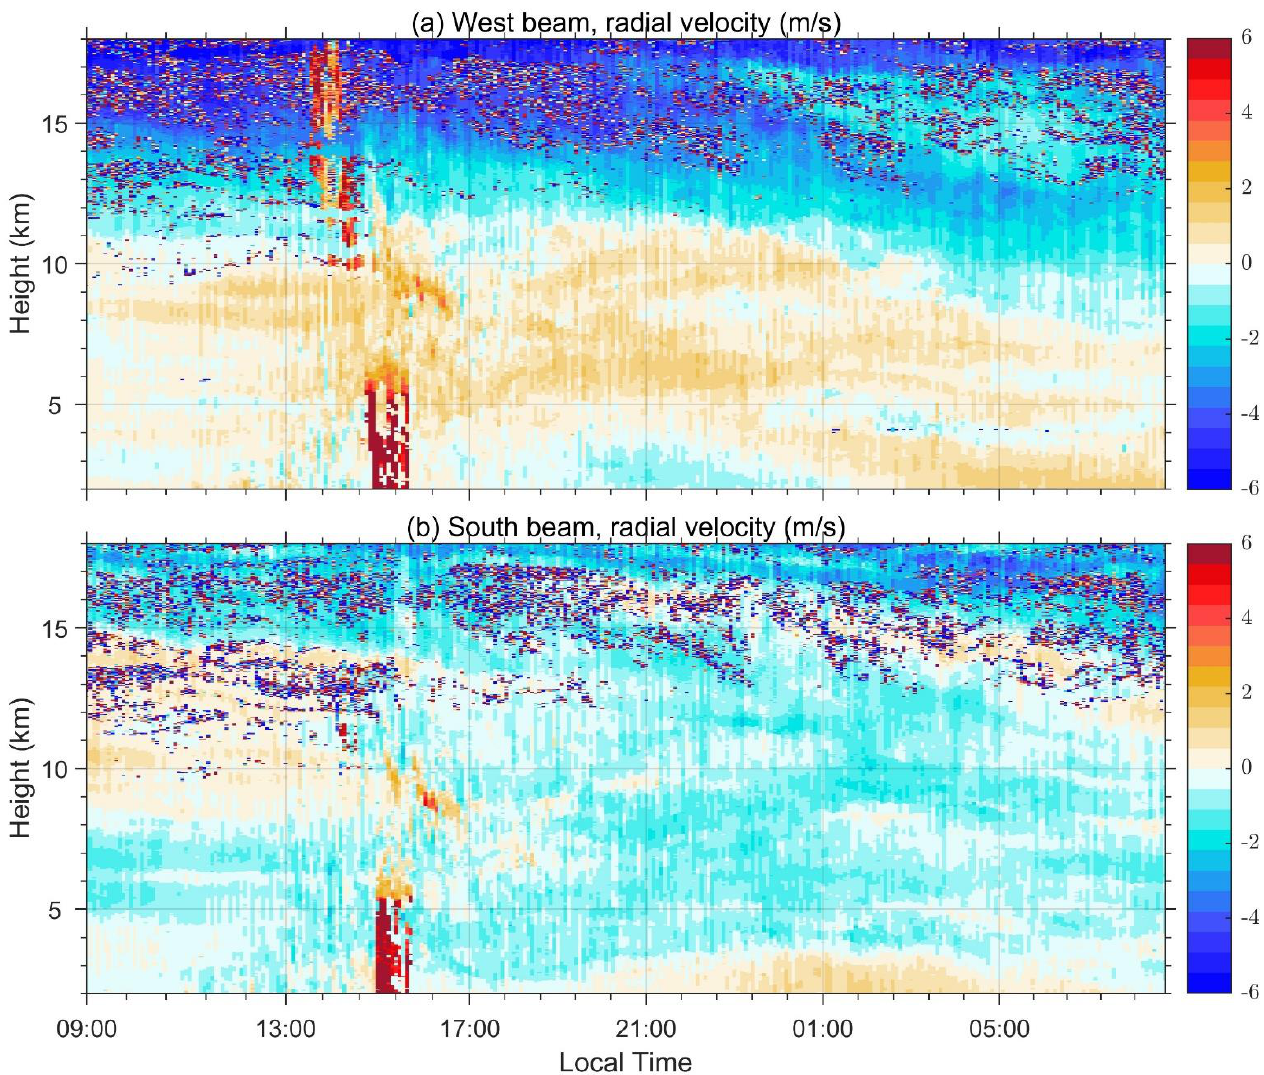
Figure 9. Radial velocity (m/s) for the west beam ( a ) and south beam ( b ) from 09:00 on 17 July 2021 to 09:00 on 18 July 2021, in experiment #1. The unit is m/s.